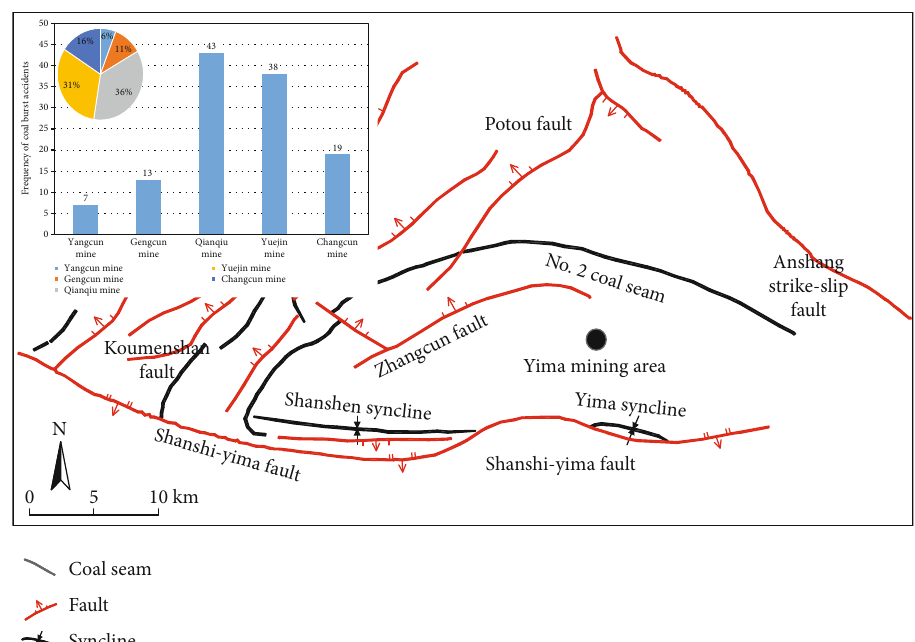
Figure 1: Schematic map of geological structures in the Yima mining area. Table 1: The generalized stratigraphy and geotechnical parameters. Thickness (m) Density Rock strata (MPa)Max. Min. Mean